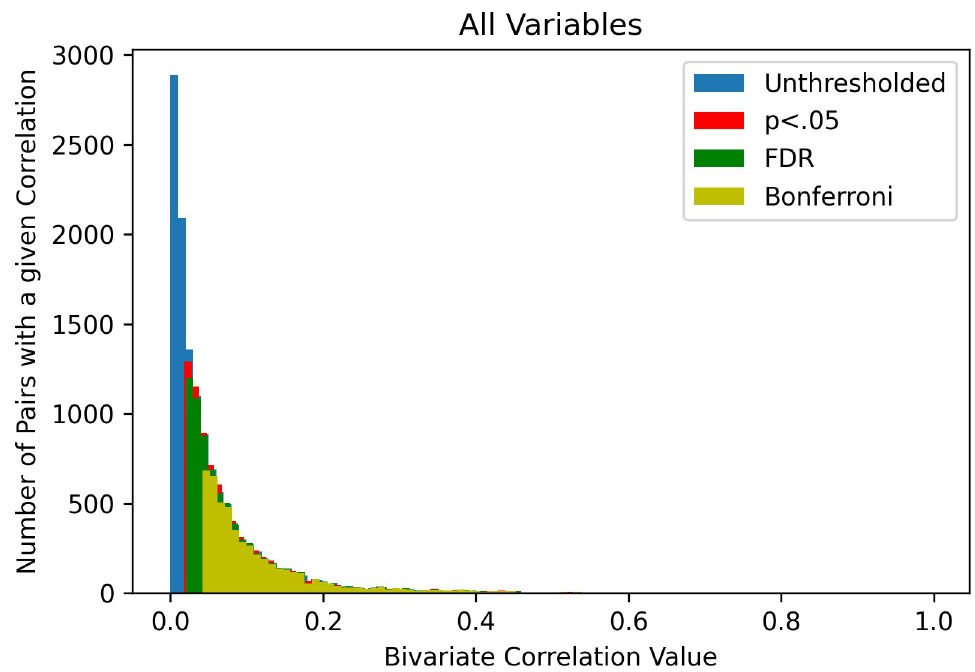
Fig 1. Effect size distributions at multiple statistical thresholds for non-covaried associations. FDR = false discovery rate.